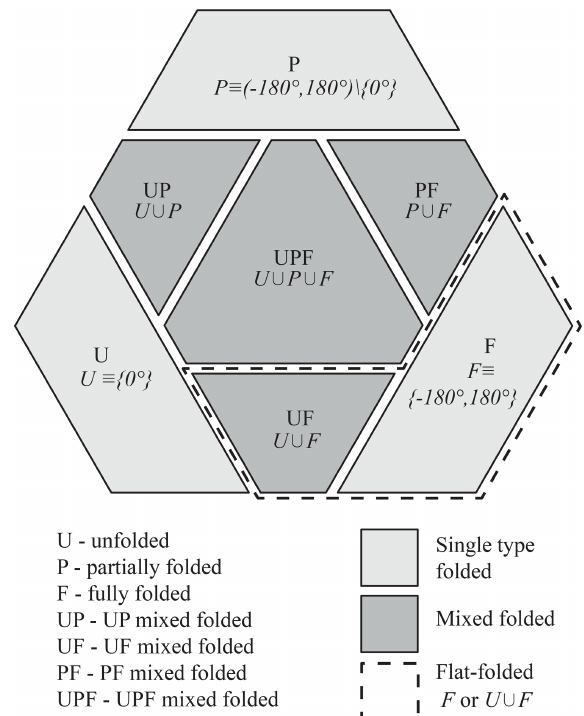
Figure 4. A graphical representation of how the fold-angle space is divided into sets (set notation and italic letters) and their corre- sponding fold-angle sets (capital Roman letters). The light gray re- gions are single type folded, the dark gray regions are mixed folded, and the two regions (F and UF) grouped using the dotted line are